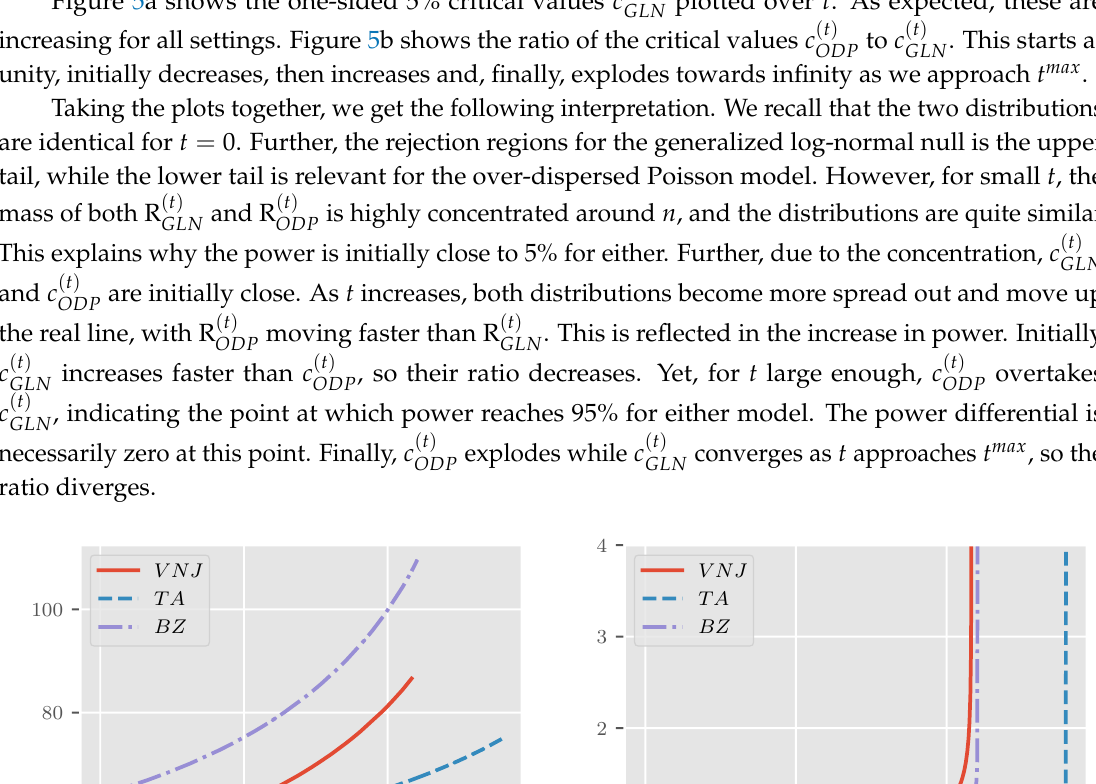
and ( b ) the ratio of critical GLN